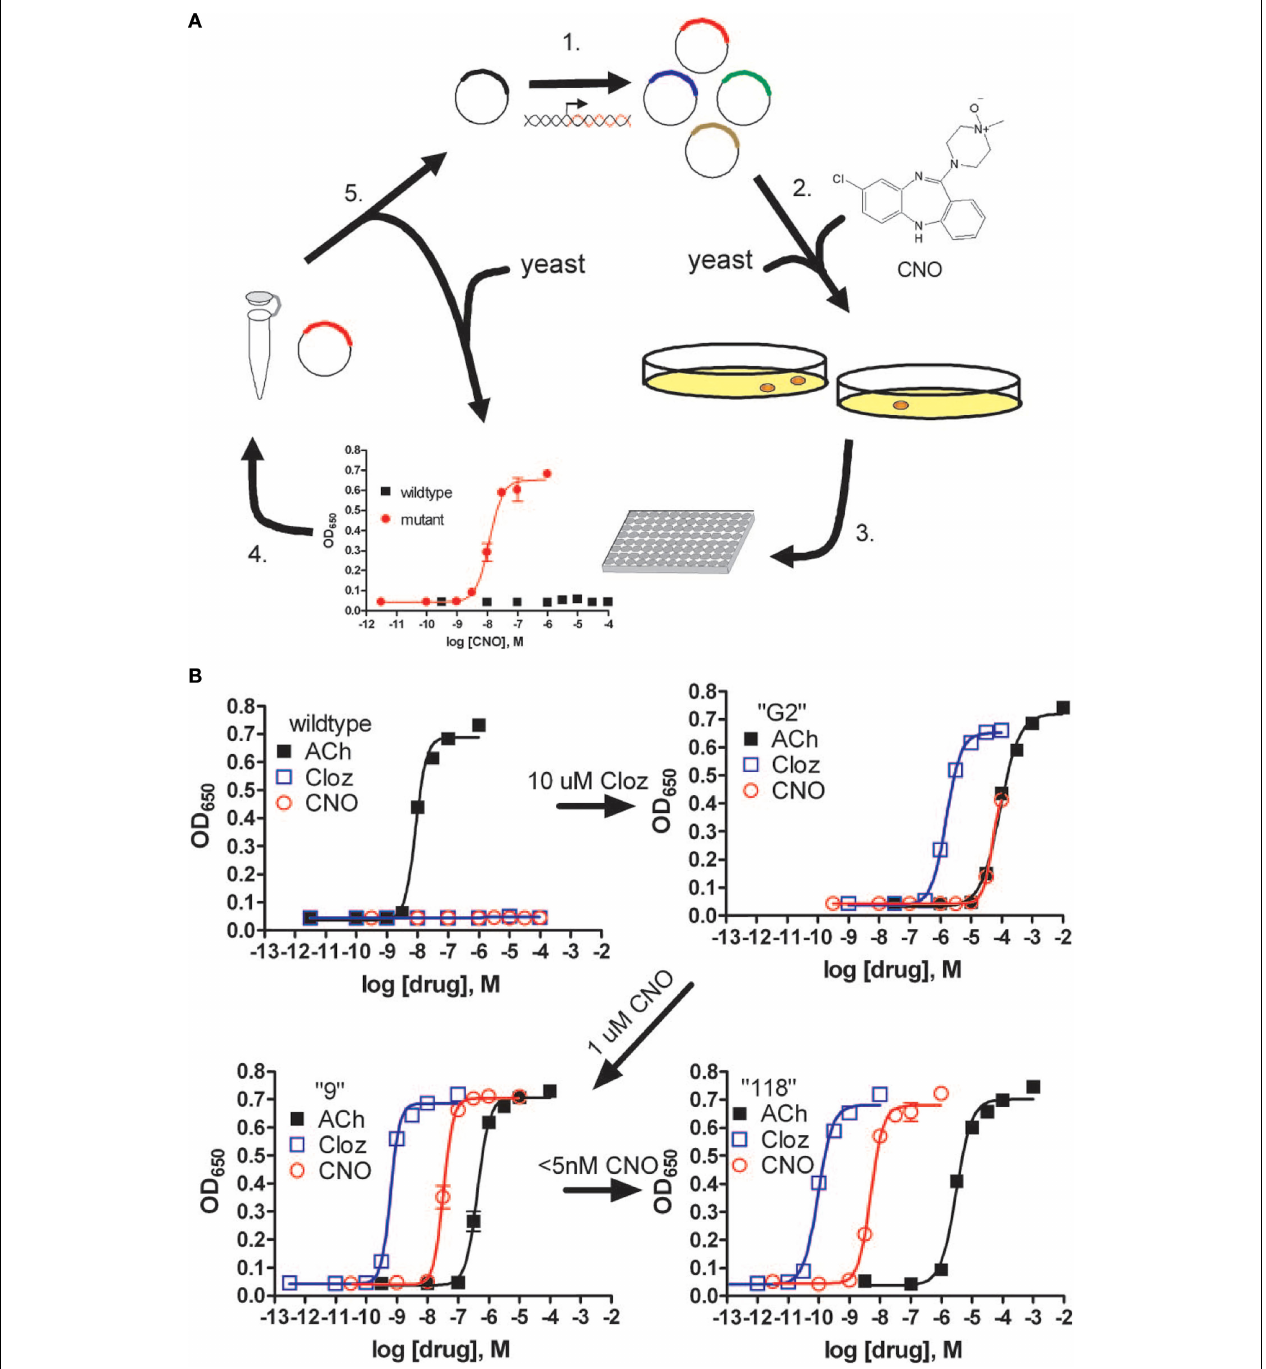
FIGURE 1 | Pharmacological profi les of an rM3 Δ i3 receptor mutant selected during directed molecular evolution for CNO responsiveness. (A) Experimental design for directed evolution of mammalian GPCRs in yeast to create DREADDs. (1) Libraries of randomly mutated rM3 Δ i3 receptors were produced by mutagenic PCR; (2) yeast-expressing mutant receptors activated by synthetic ligands (e.g., CNO) were selected for by growth on nutrient defi cient medium; (3) mutants were verifi ed by secondary liquid growth assays in 96-well plates; (4) plasmid DNA was isolated from yeast; (5) clones were retransformed into yeast to pharmacologically profi le mutants by liquid growth assays, and those